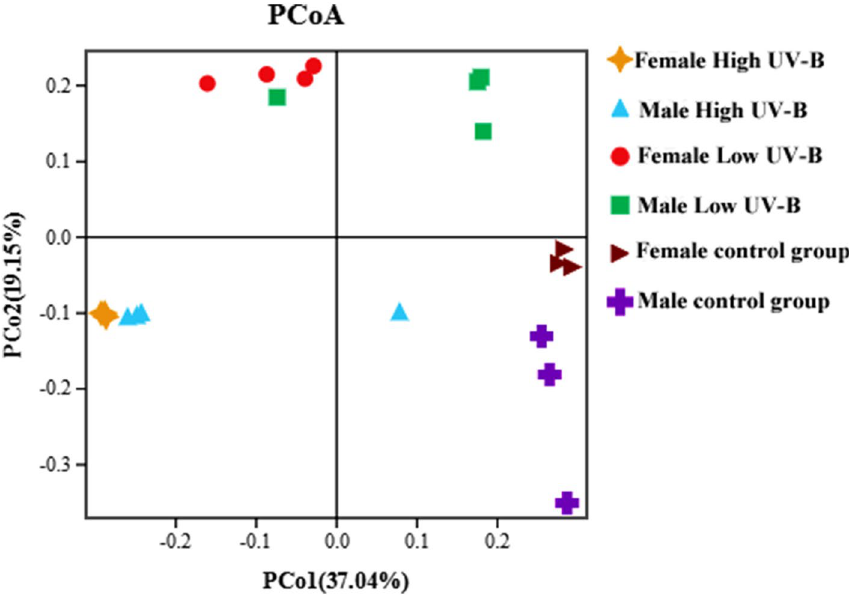
Figure 1. Principal coordinate analysis (PCoA) results of the epiphytic bacterial community on S. thunbergii under increased UV-B